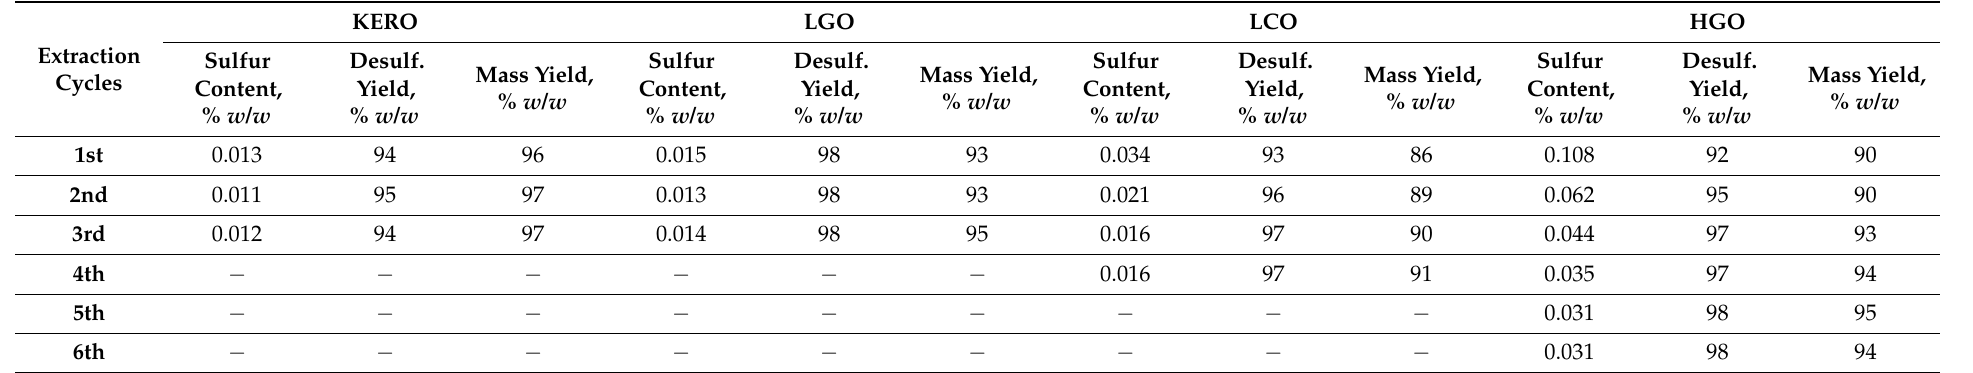
Table 6. Sulfur content, desulfurization yield and mass yield of the surrogate raffinates during the multiple-stage extractions with fresh [BMIM][Br].